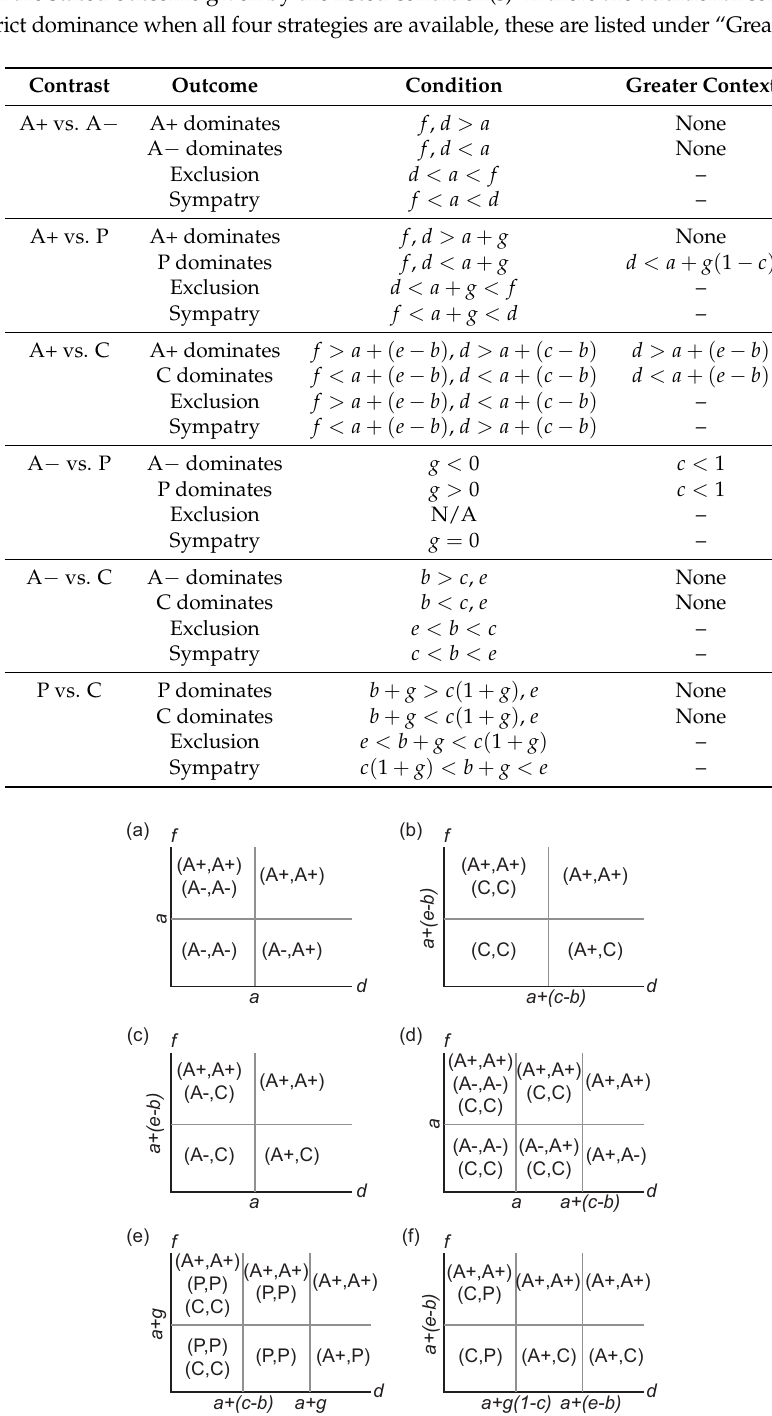
Table 3. Pairwise contrast of strategies. Each pair of strategies is compared in a reduced two-strategy game, with the stated outcome given by the listed condition(s). If there are additional conditions that arise for strict dominance when all four strategies are available, these are listed under “Greater Context”.